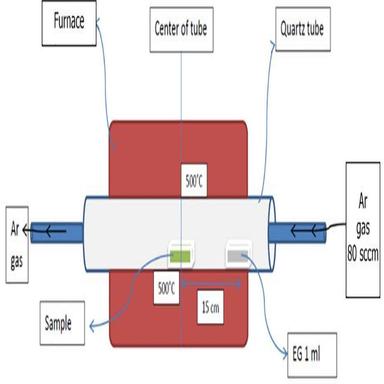
Schematic setup for the synthesis of Ni-NSAs@Ni foam via a one-step thermal decomposition process conducted in a horizontal quartz-tube furnace.